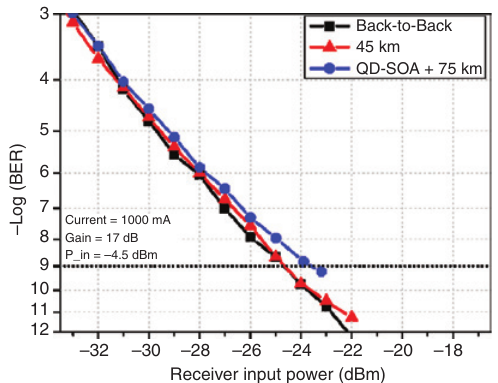
Figure 11: Bit error rates of a 42.7-Gbit/s NRZ OOK signal from a QD MLL and a QD SOA across 45 and 75 km compared to a back-to-back BER measurement of the QD